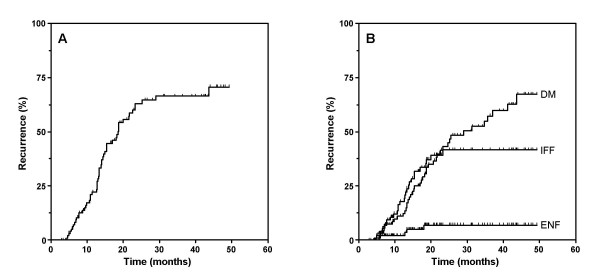
Pattern of failure. A. Probability of any disease recurrence by Kaplan-Meier method. B. Pattern of Failure. Distant metastasis (DM) remains the most common site of disease failure, followed by IFF and any ENF (p < 0.0001, log-rank test). Five of 115 patients developed ENF and only 2 of 5 ENFs were isolated ENFs.